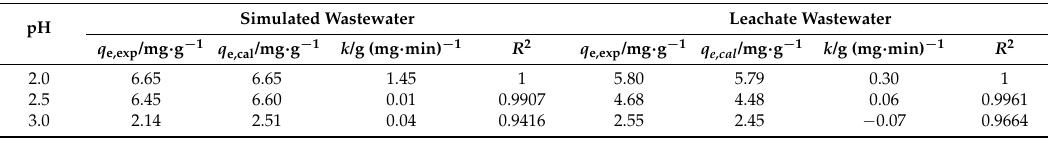
Table 1. Pseudo second-order kinetic parameters for Cr(VI) removal from two wastewaters by BFe 0 NPs (4%) at different pH values.